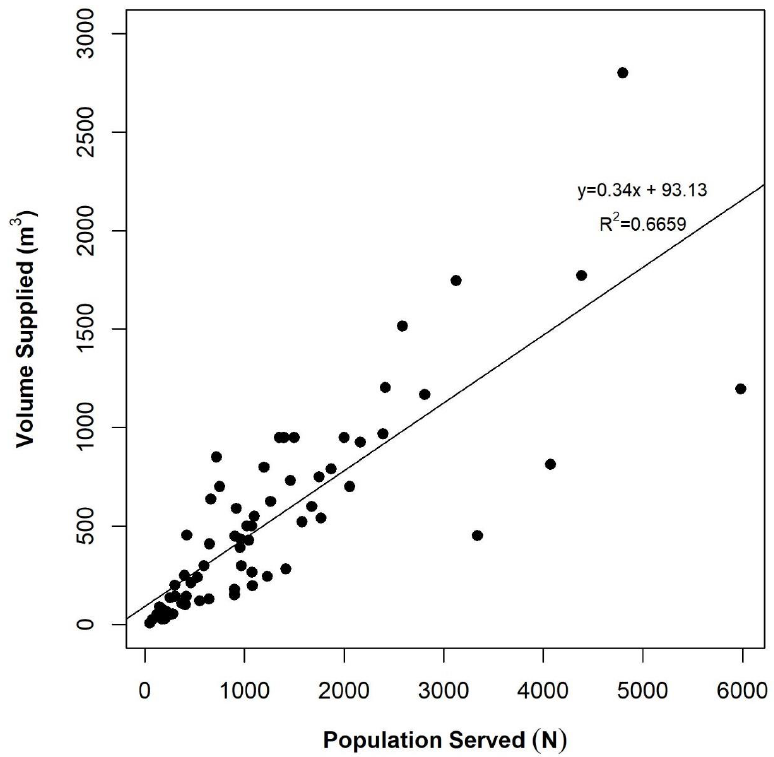
Figure 4. Supply volume (per day) and population served for Group Water Schemes abstracting from surface waters.